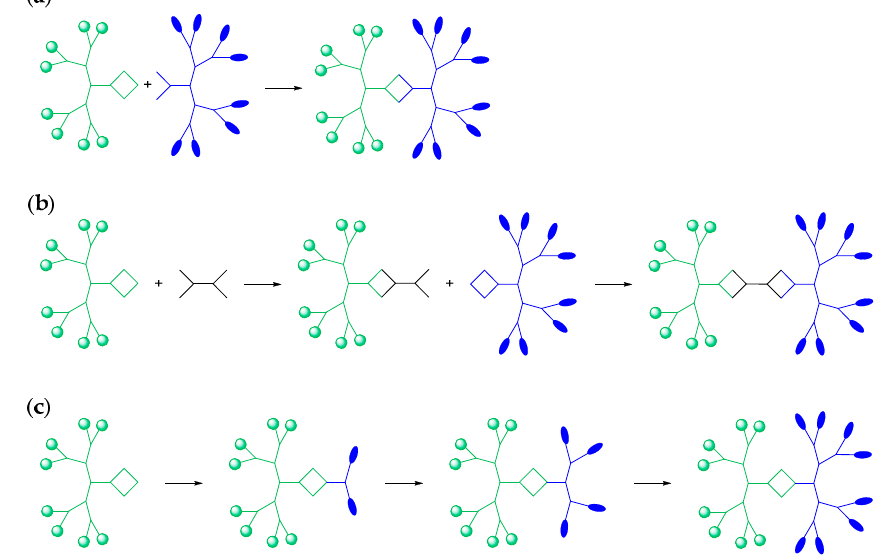
Figure 2. Main synthesis methods for amphiphilic JDs: ( a ) convergent method with two complementary dendrons; ( b ) convergent method with two dendrons complementary coupled to a multifunctionalized core; and ( c ) divergent method.